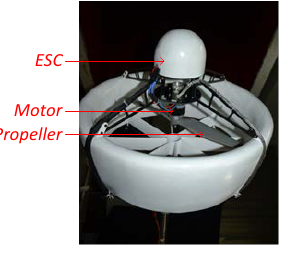
Figure 1. The prototype electric Micro Air Vehicle (MAV).